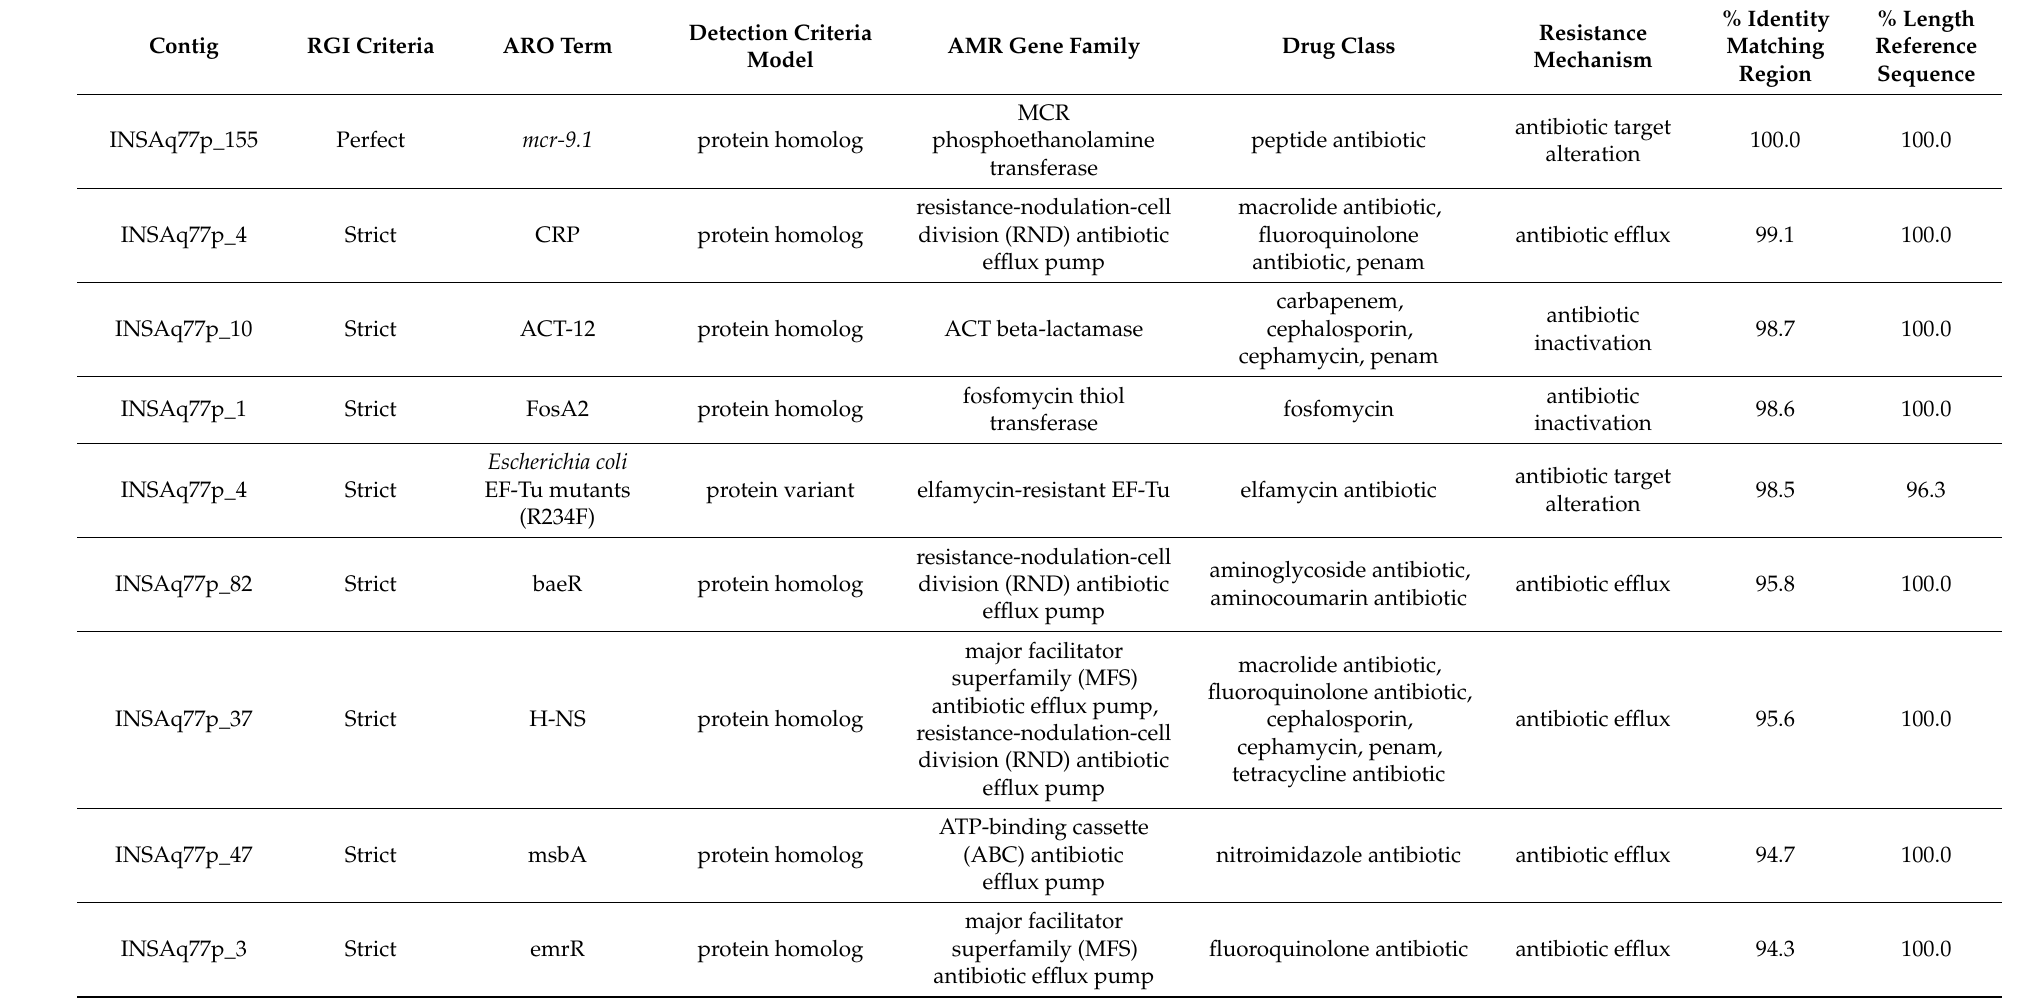
Table 1. Perfect and strict best-hit results by predicted gene, obtained using the Resistance Gene Identifier